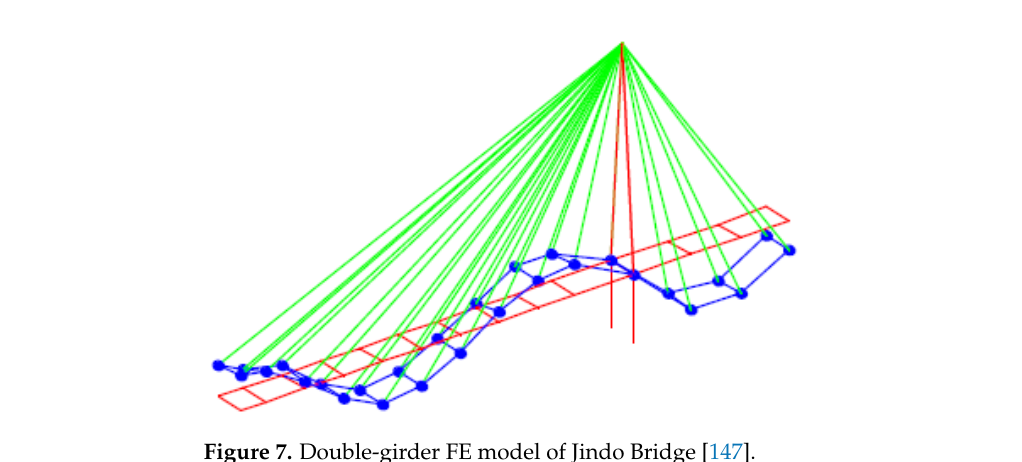
Figure 7. Double-girder FE model of Jindo Bridge [147].